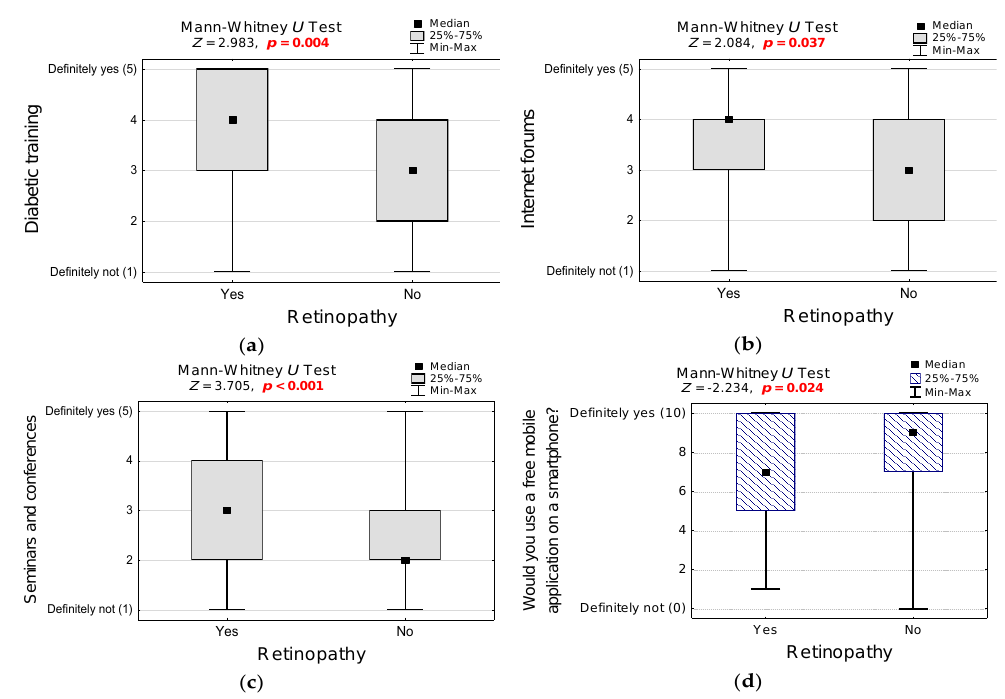
Figure 8. ( a ) Responses to the question about the sources of knowledge about the disease and methods of management (diabetic training) in groups of patients differing in the presence of diabetic retinopathy and the results of the non-parametric test of significance; ( b ) responses to the question about the sources of knowledge about the disease and methods of management (Internet forums, Facebook, etc.) in groups of patients differing in the presence of diabetic retinopathy and the results of the non-parametric test of significance; ( c ) responses to the question about the sources of knowledge about the disease and methods of management (seminars and conferences) in groups of patients differing in the presence of diabetic retinopathy and the results of the non-parametric test of significance; ( d ) responses to the question about the possible use of a free mobile application to monitor the disease in groups of patients differing in the presence of diabetic retinopathy and the result of the non-parametric significance test .